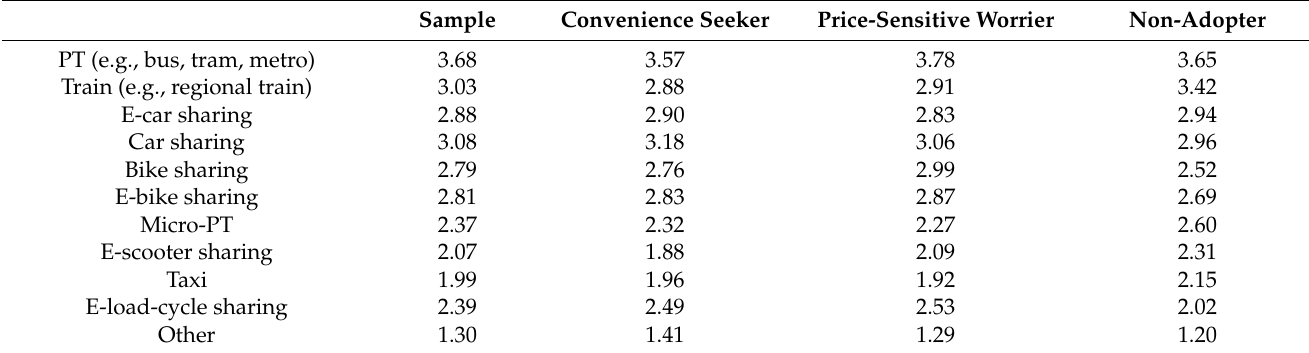
Table A6. Results for direct question on preferred transport modes to be included in MaaS bundle (mean).